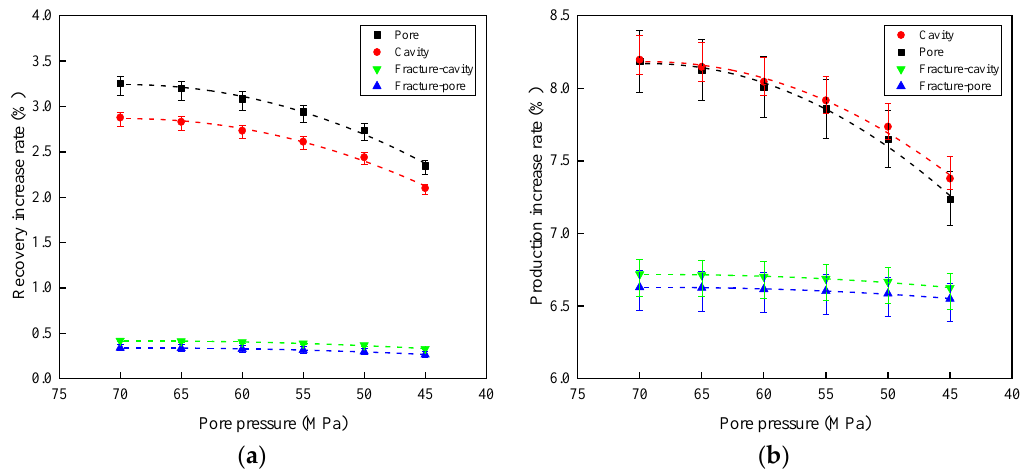
Figure 13. Influence of SB on reservoir development: ( a ) gas recovery; ( b ) gas production.